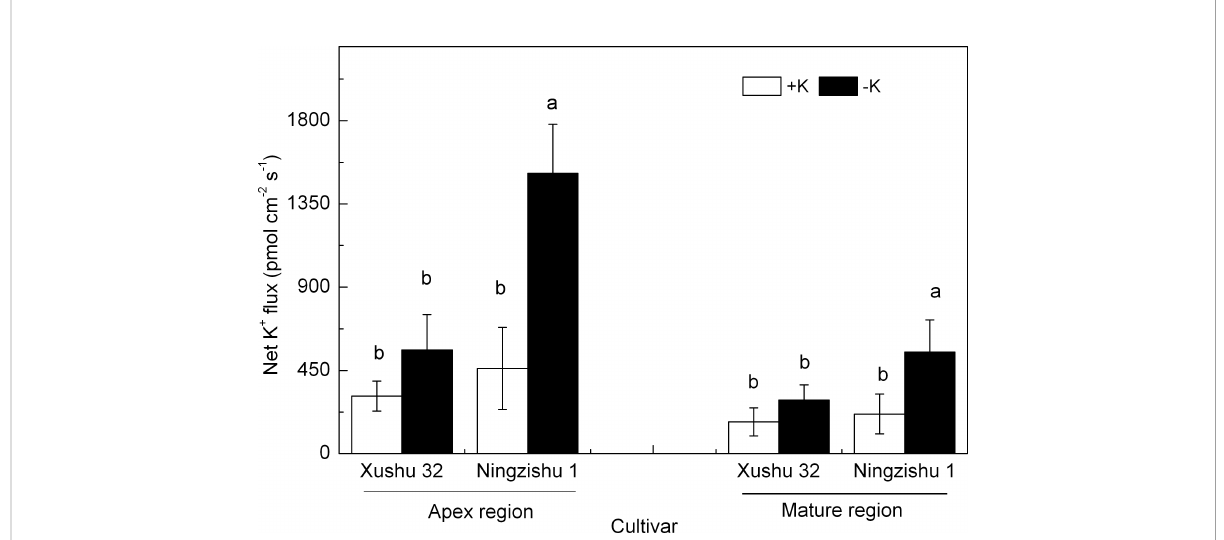
FIGURE 3 Effects of K de fi ciency on steady-state net K + ef fl ux in adventitious roots of two sweet potato genotypes (Xushu 32 and Ningzishu 1). Steady- state net K + fl ux measured from root apex and mature regions after 10 days of K treatment. Apex region, 500 m m from the root tip; mature region, 15 mm from the root tip. Columns labeled with different letters in the same region indicate signi fi cant differences at 0.05